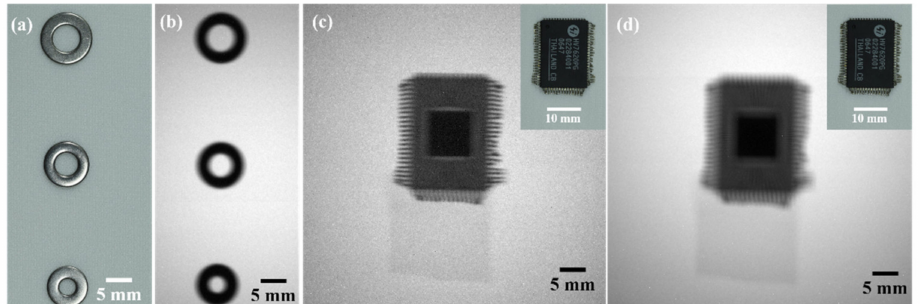
Figure 7. ( a ) Optical picture of stainless steel ring; ( b ) contact X-ray image of stainless steel ring obtained from single row emission of the device at 29 kV; ( c ) contact X-ray image of integrated circuit chip obtained from single row emission of the device at 29 kV, and inset shows the optical image; ( d ) contact X-ray image of integrated circuit chip obtained from all rows emission of the device at 29 kV, and inset shows the optical